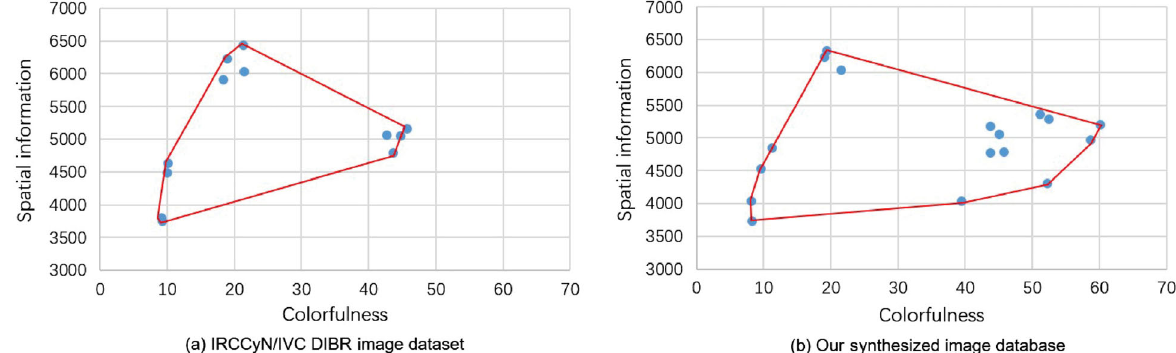
Fig. 7 Spatial information versus colorfulness scatter plots for (a) the IRCCyN/IVC DIBR image dataset and (b) our proposed augmented synthesized image dataset. Red lines indicate the convex hull of the points in each scatter plot, indicating the range of scene diversity.